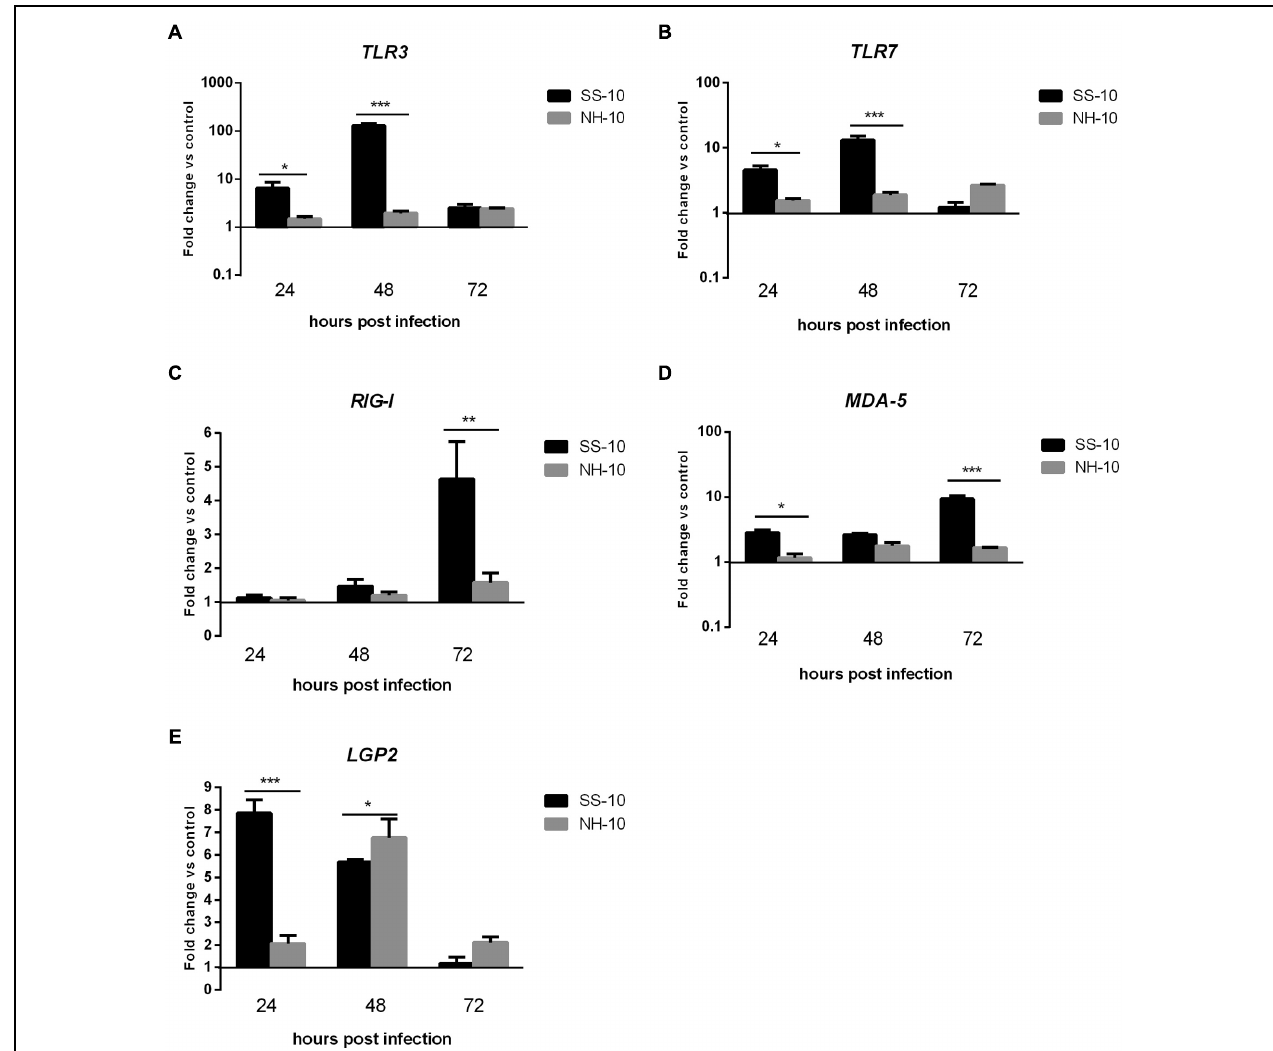
FIGURE 3 | Fold change expression of PRRs in the thymuses of infected ducks in response to SS-10 and NH-10. (A) TLR3 , (B) TLR7 , (C) RIG-I , (D) MDA5 , (E) LGP2 . The Y -axis represents the fold change in target gene expression in the experimental group relative to those in the control group and presented as the mean values ± standard deviation ( n = 3). Significance is analyzed with two-way ANOVAs between SS-10 group and NH-10 group at the same time points ( ∗ p < 0.05, ∗∗ p < 0.01, ∗∗∗ p < 0.001). Error bars indicate standard